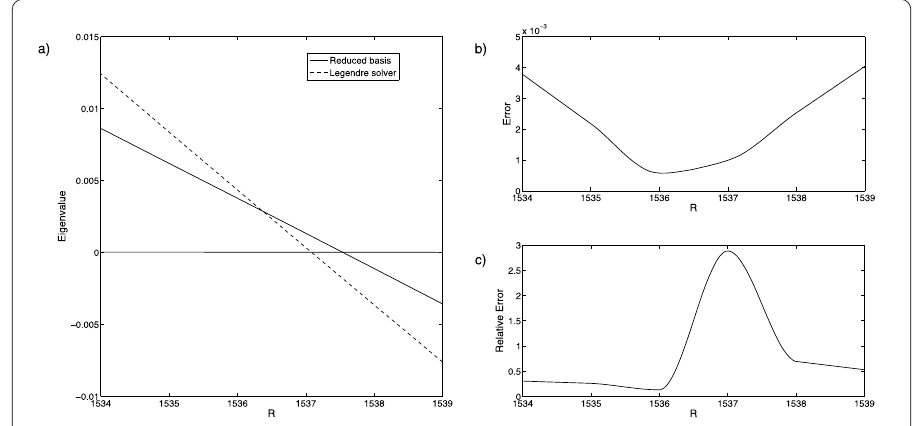
Figure 3 ( a ) Eigenvalue with maximum real part near the bifurcation point. Dashed line for the Legendre solver and solid line for the post-processed reduced basis. ( b ) Norm of the difference between Re( σ 1 ) obtained with Legendre collocation and with a post-processed reduced basis method based on Legendre collocation. ( c ) Norm of the difference between Re( σ 1 ) obtained with Legendre collocation and with a post-processed reduced basis method based on Legendre collocation divided by the norm of Re( σ 1 ) obtained with Legendre